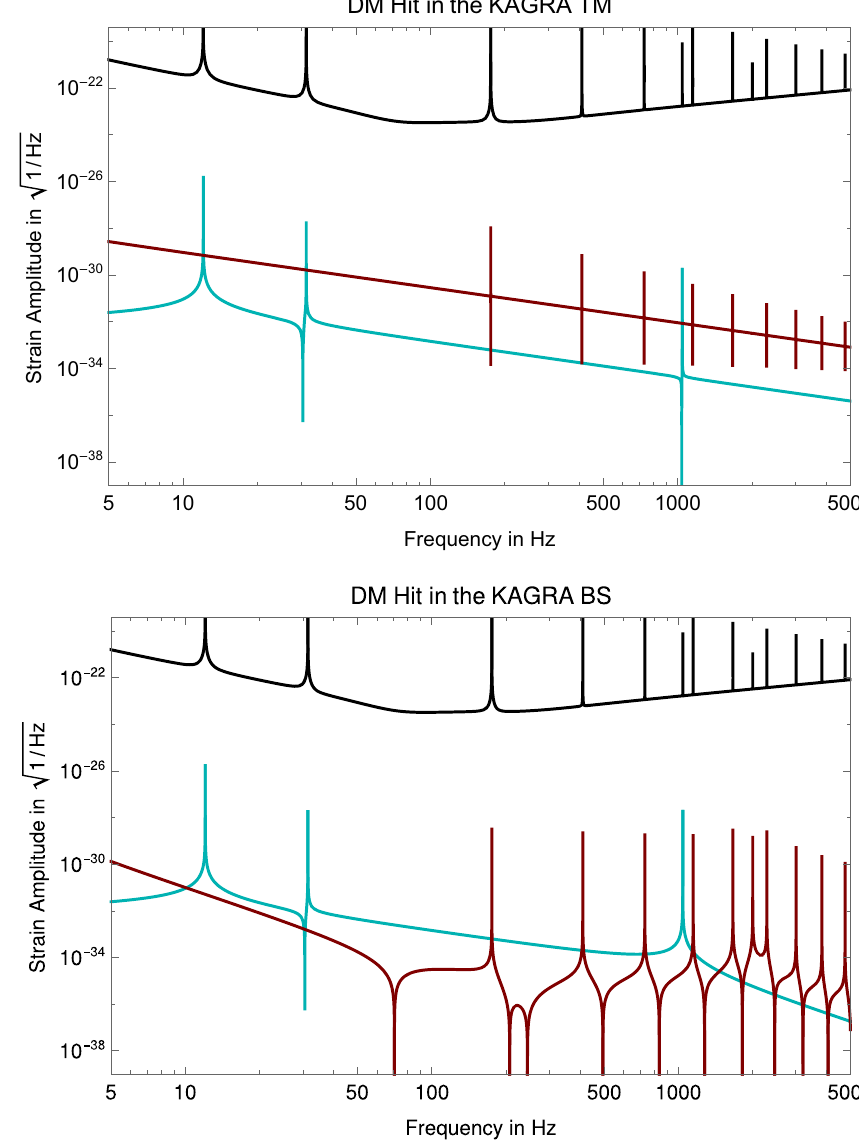
Fig. 3 Comparison of strain amplitudes of noise shown as black line and a DM hit in the TM in vertical (horizontal) direction shown as aqua (maroon) line. For more details, see main text